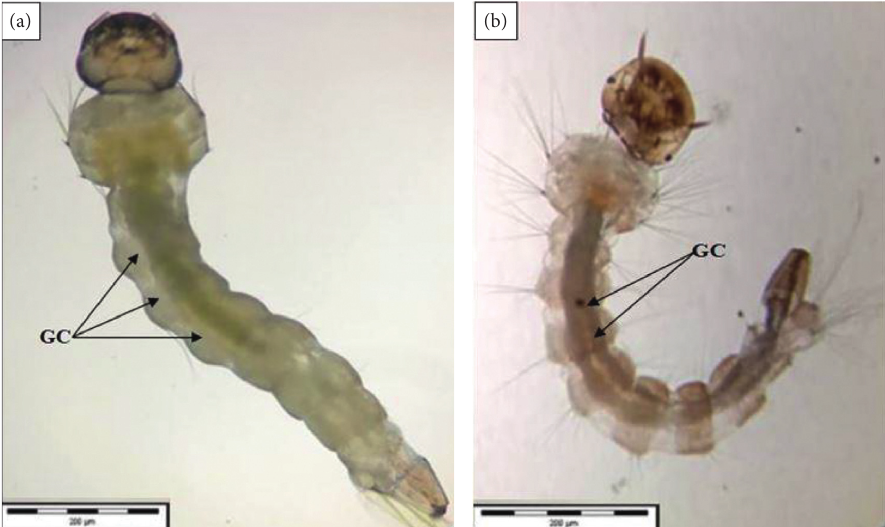
Figure 4: Morphological midgut content induced by Clitoria ternatea . (a) Midgut content view in larvae of Aedes aegypti. (b) Midgut content view in larvae of Aedes albopictus . Note . Arrows indicate the plant extracts (dark greenish color); GC: gut content (after 24